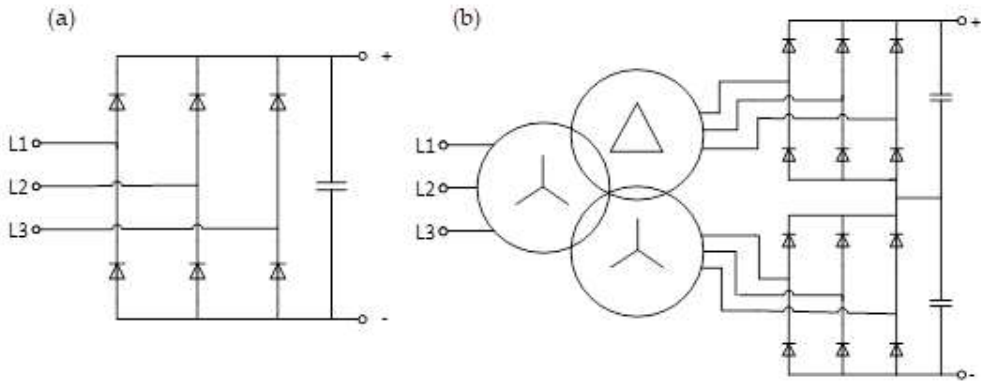
Figure 3. Used models of the 6-pulse ( a ) and 12-pulse ( b ) rectifiers.